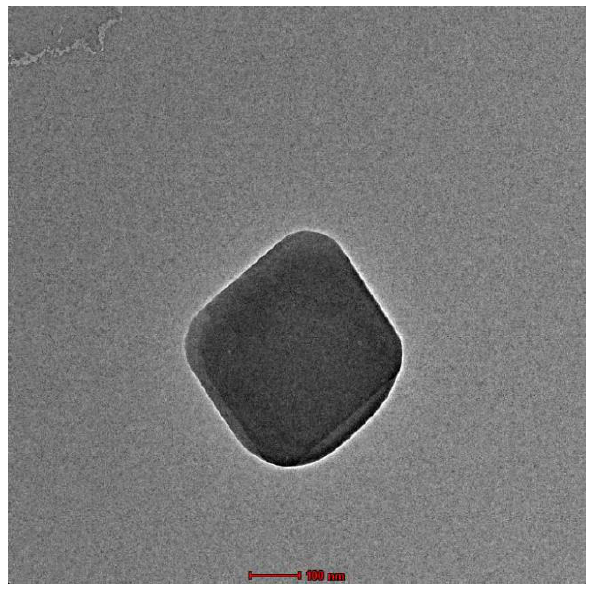
Figure 12. TEM image of an O-, S-, K-, Pb-, and Na-containing particle sampled using a vacuum pump from the fault gas near a concealed ore body of the Dongshengmiao deposit.